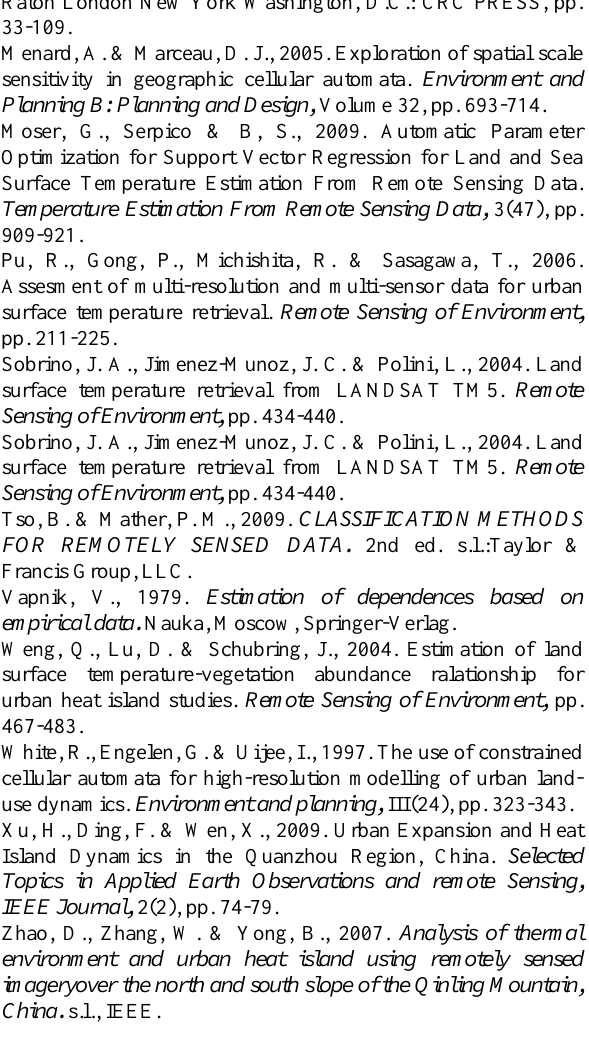
Table 1 indicates that the best radius for computing neighborhood is 20 pixels. However, as it was mentioned before, the proper neighborhood size depends on data spatial resolution and difference between simulation time